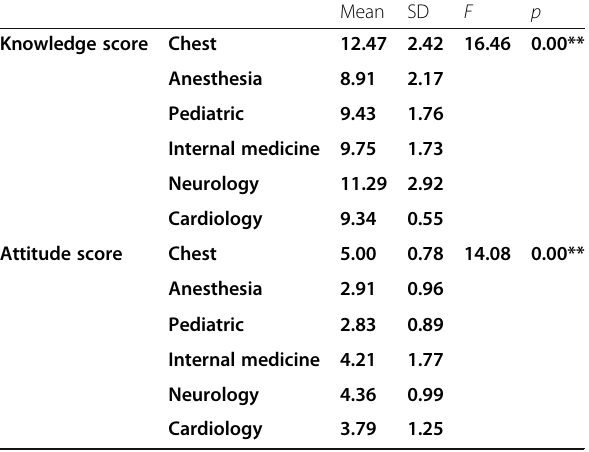
Table 6 OSA knowledge and attitude scores in relation N %